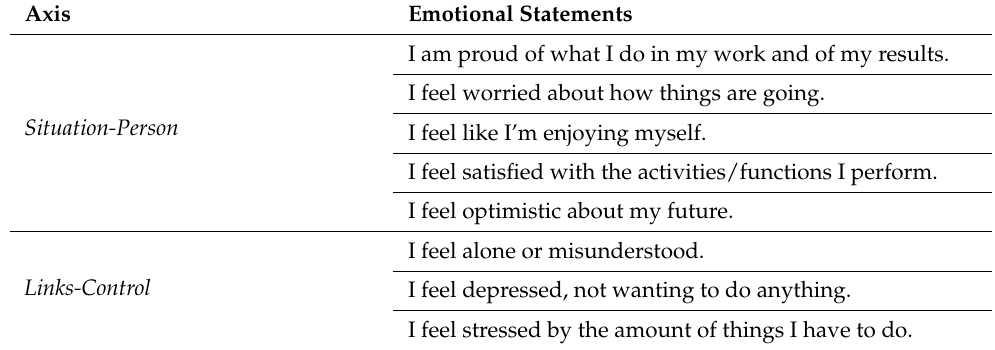
Table 1. Socioemotional Well-Being